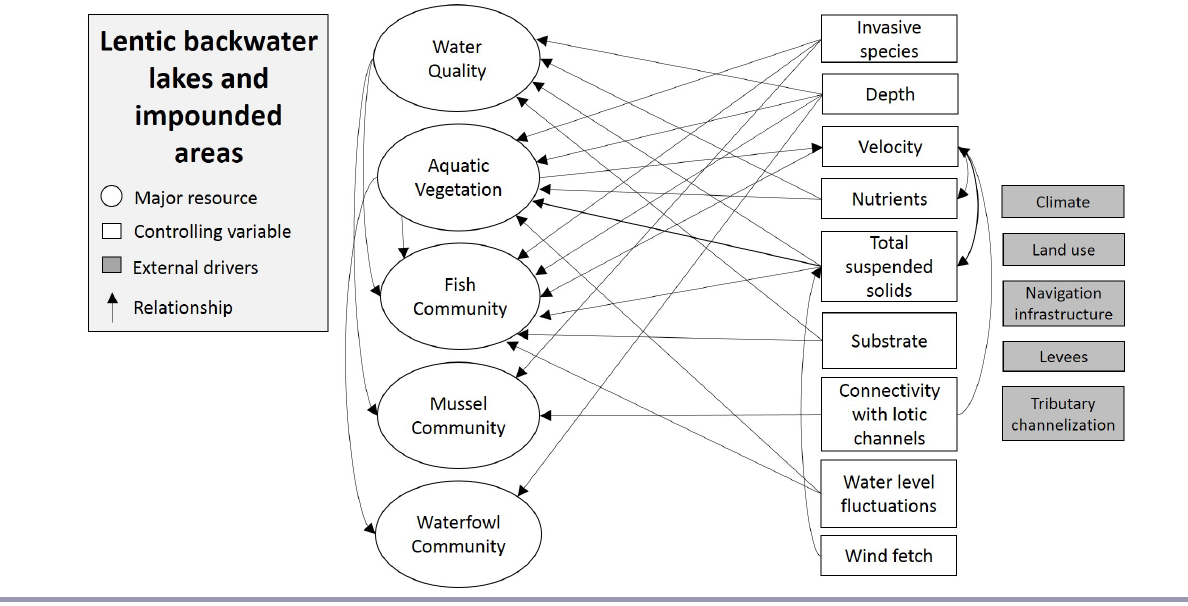
Fig. 6 . Water quality, aquatic vegetation, fish community, mussel community, and waterfowl community represent the major resources of lentic backwater lakes and impounded areas. The nine controlling variables identified represent the major factors that influence major resource dynamics in the lentic